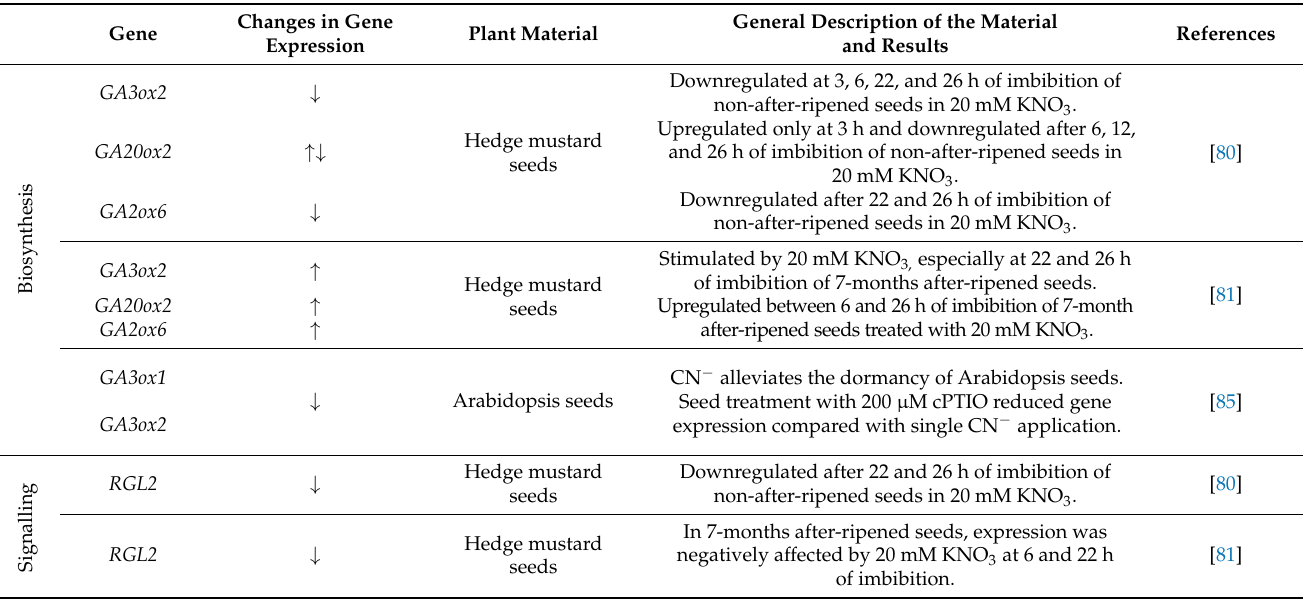
Table 3. NO-dependent changes in the expression of genes related to GA metabolism and signalling in seeds.